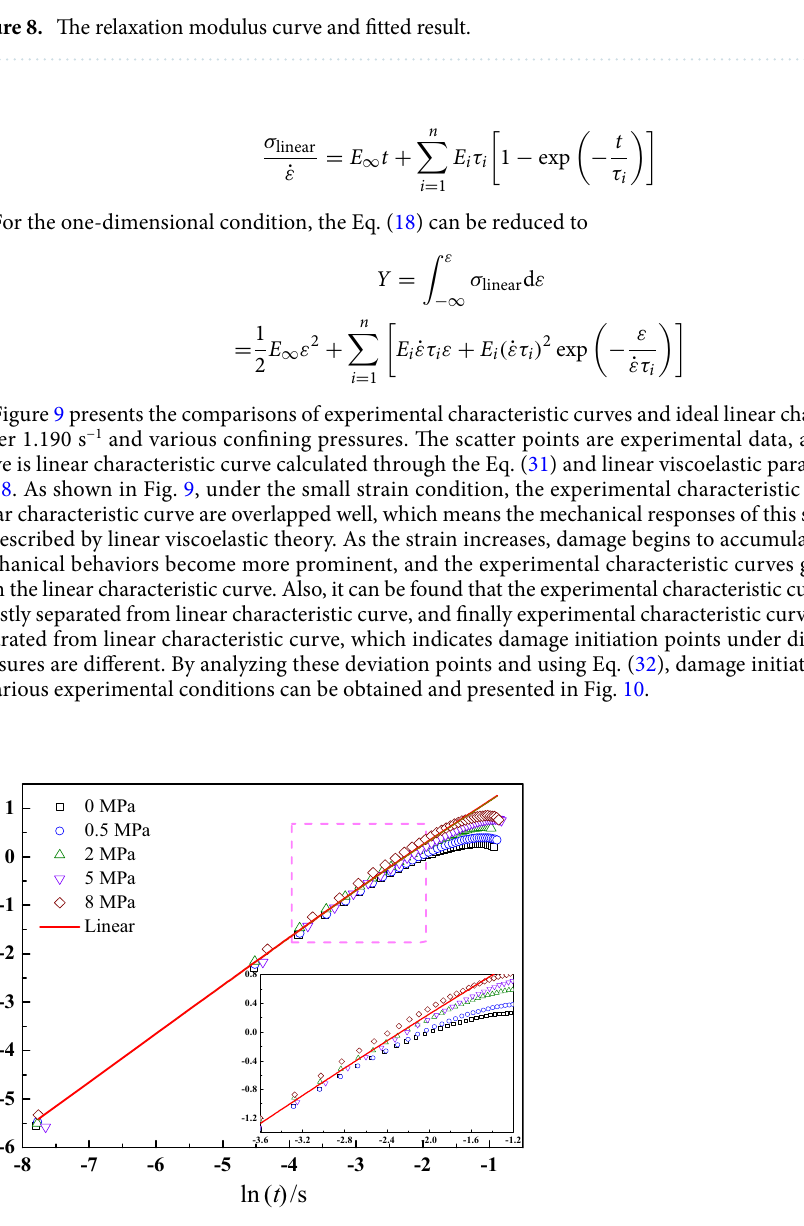
Figure 9. Comparisons of experimental characteristic curves and linear characteristic curve at 1.190 s −1